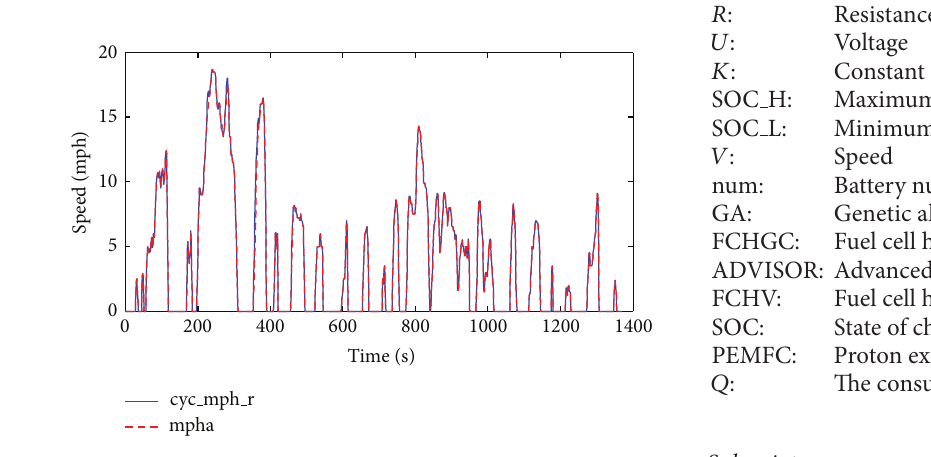
= 2 kW, the speed of simulation and drive cycle. Figure 13: 𝑃 motor